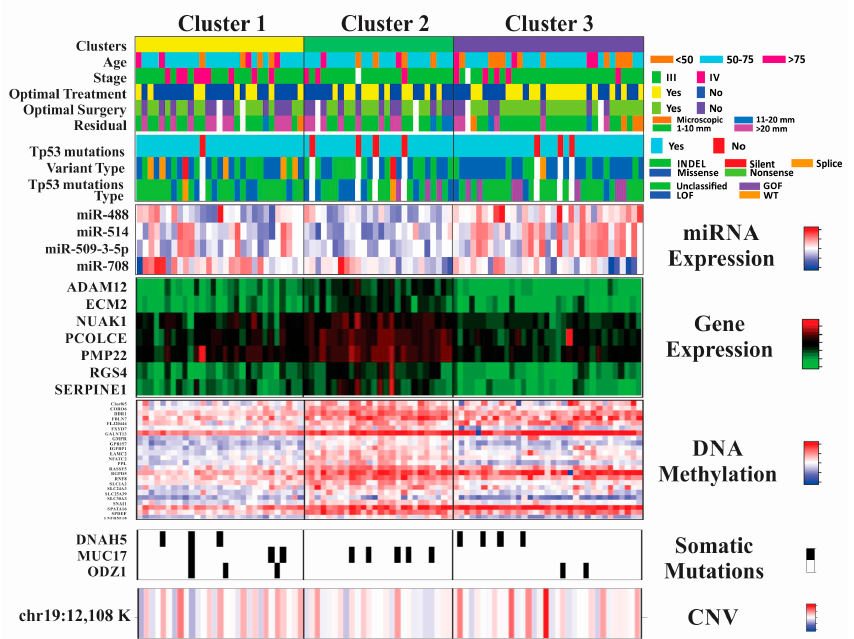
Figure 3. Clinical-molecular characteristics of the three clusters. At the top are the different clusters: 1 in yellow, 2 in green, 3 in purple. Below them are the clinical profiles with the variable in the left margin (age, stage, optimal treatment, optimal surgery and residual disease after surgery) and the color-code for each category in the right margin. Underneath clinical information there is a representation of TP53 somatic mutation features: presence or status, variant, and mutation type. The last five heatmaps represent the top molecular features with specific color codes for their respective values at the right margin. Only molecular features that were most discriminating for this three-cluster model and passed a selection with a threshold value of > 95th percentile were included in the representation of the final 3-cluster model. Names of all features are detailed in Appendix A.